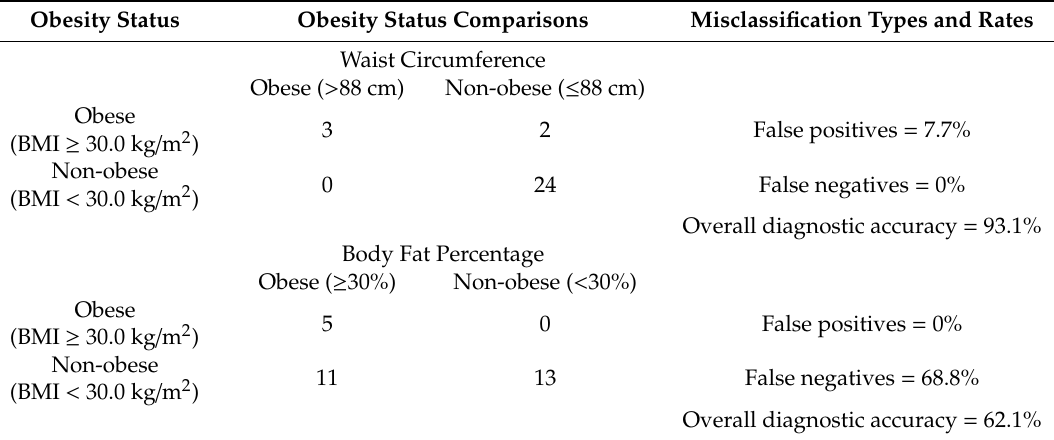
Table 2. Rates of false positives and false negatives using BMI-defined obesity classification in comparison to WC-defined and BF%-defined obesity for women ( n =